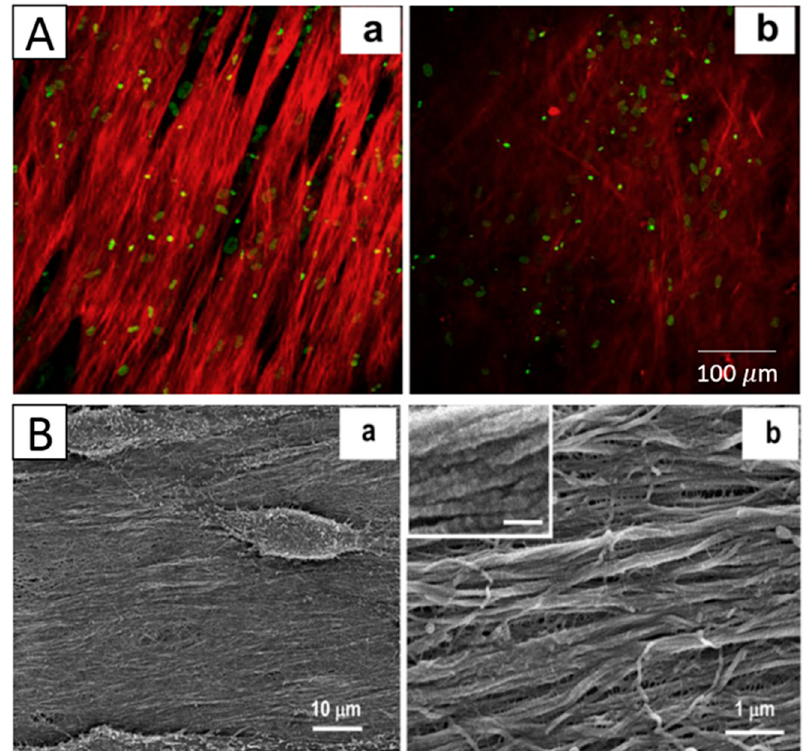
Figure 8. ( A ) Two-photon images of hCSSCs-secreted ECM varying with: ( a ) aligned fibrous, ( b ) random fibrous PEUU mat and ( B ) SEMs of hCSSCs and the elaborated ECM on the ( a , b ) aligned fibrous. Reproduced from [8], with permission from © 2012 Elsevier.